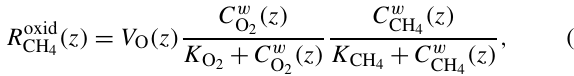
Figure 2. Residual histograms and autocorrelation functions of the error terms (cid:15) t in the objective function, Eq. (24), show that nei- ther the CO 2 nor the CH 4 residuals are autocorrelated and that they closely follow the Laplace distribution. The results shown are for the residuals from the posterior mean